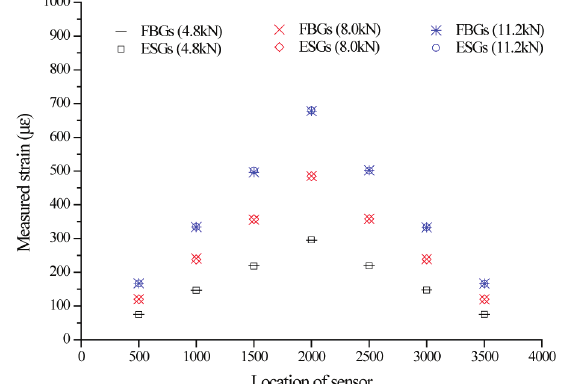
Fig. 6. Measured strains by both of 7 FBG sensors and 7 ESGs